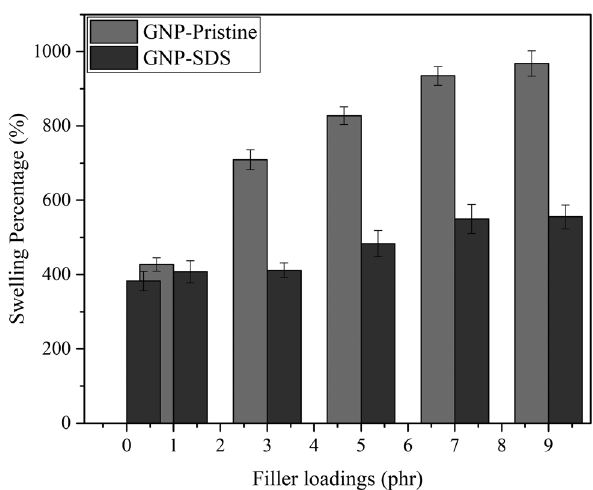
Figure 4: Swelling percentage of NRL/GNP - pristine and NRL/GNP – SDS with increasing GNP